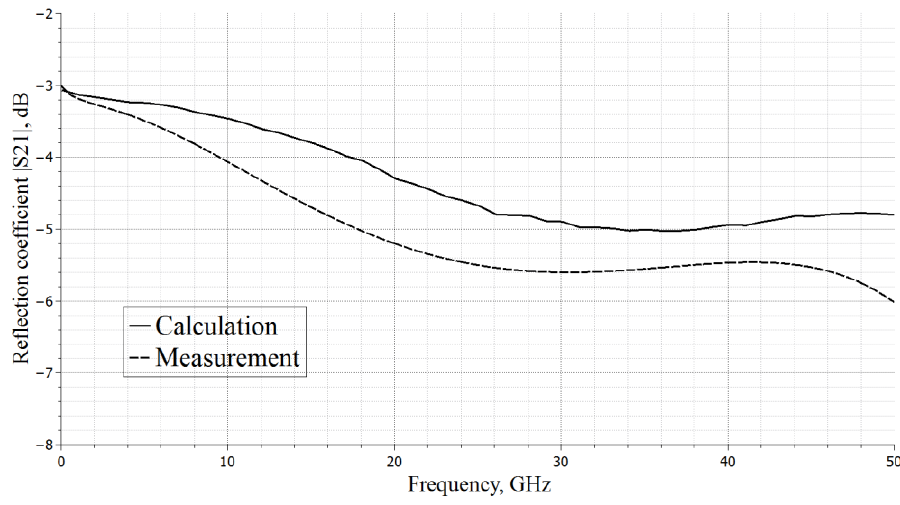
Fig. 8. Measured vs simulated S21 (transmission losses,